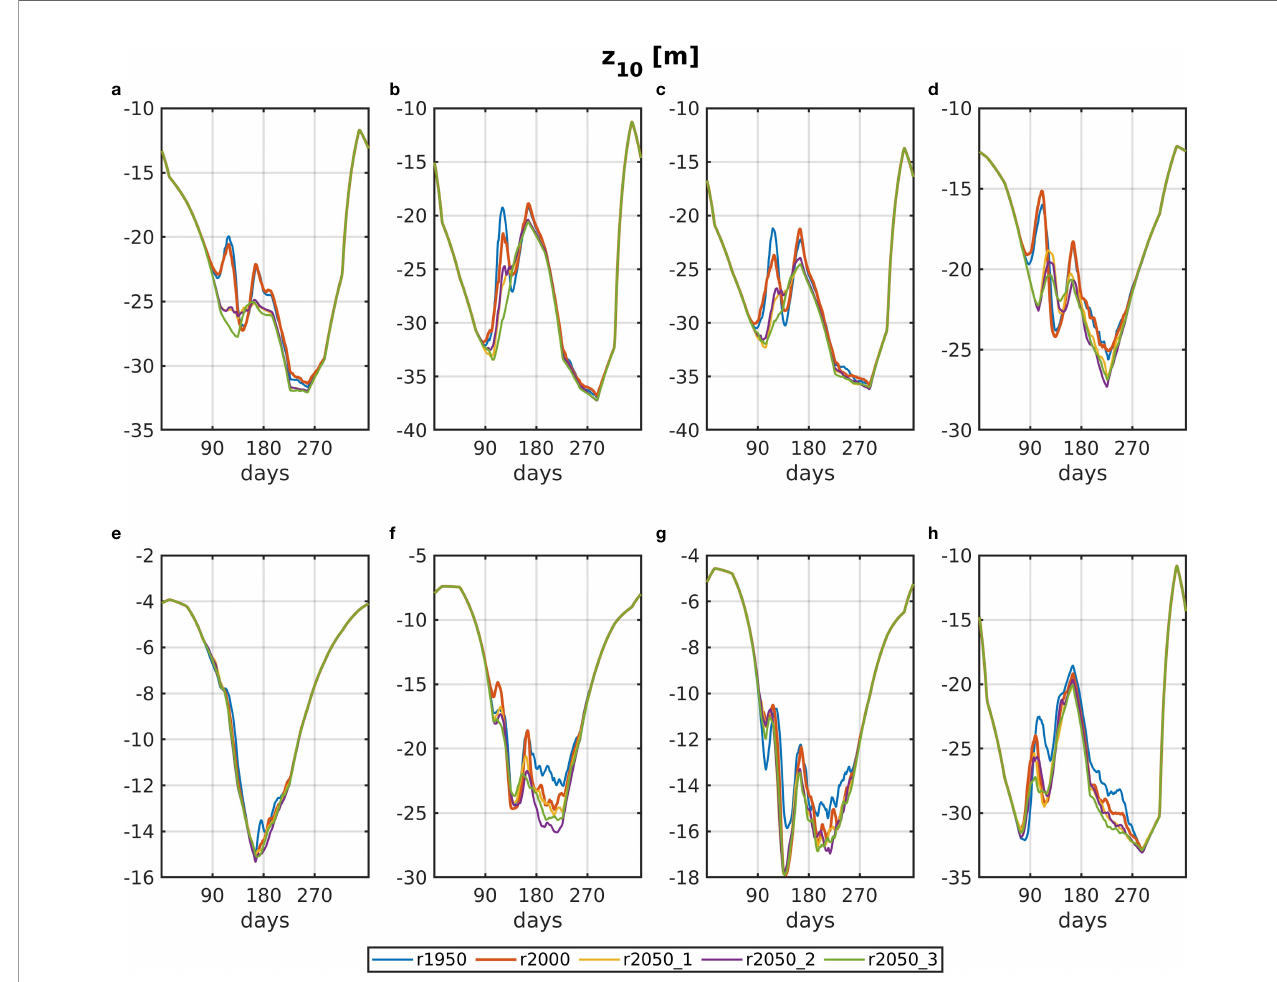
FIGURE 5 | Daily climatology of <Z> 10 for all base runs (blue: r1950, red: r2000, yellow: r2050_1, purple: r2050_2, green: r2050_3). The letter tags in the panel ’ s titles refer to the areas, which are shown in Figure 1